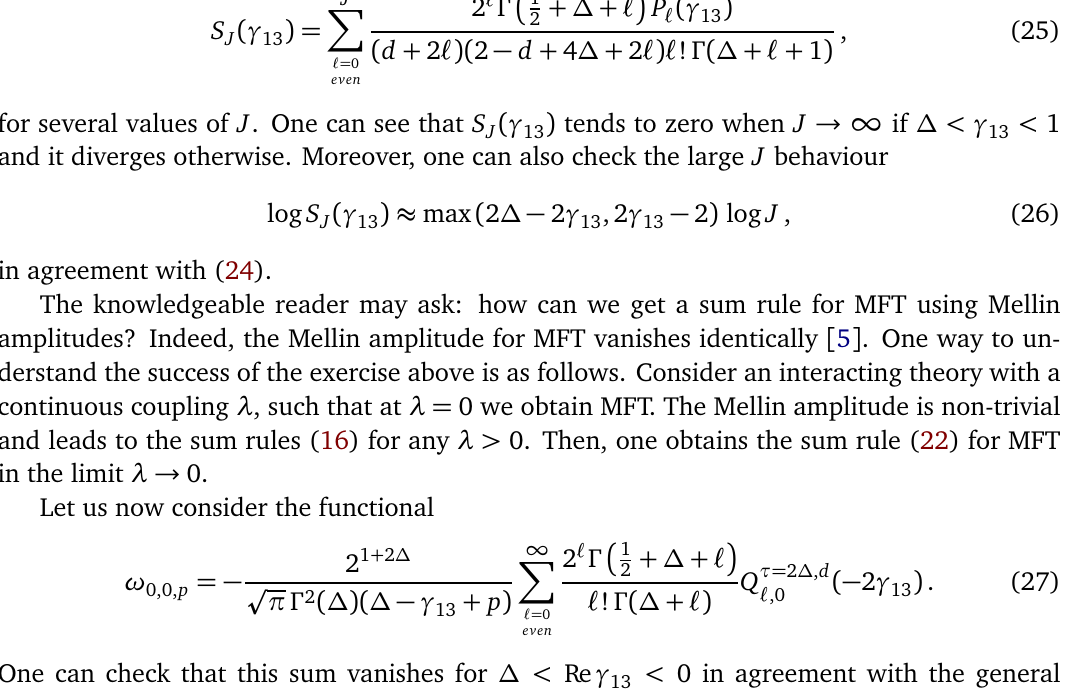
( γ ) defined in (25) for d = 3 and ∆ = 3 J 13 < 1 the partial sum converges to zero as expected. 13 = 4 and use a log-log plot to exhibit the large J behavior 13 5